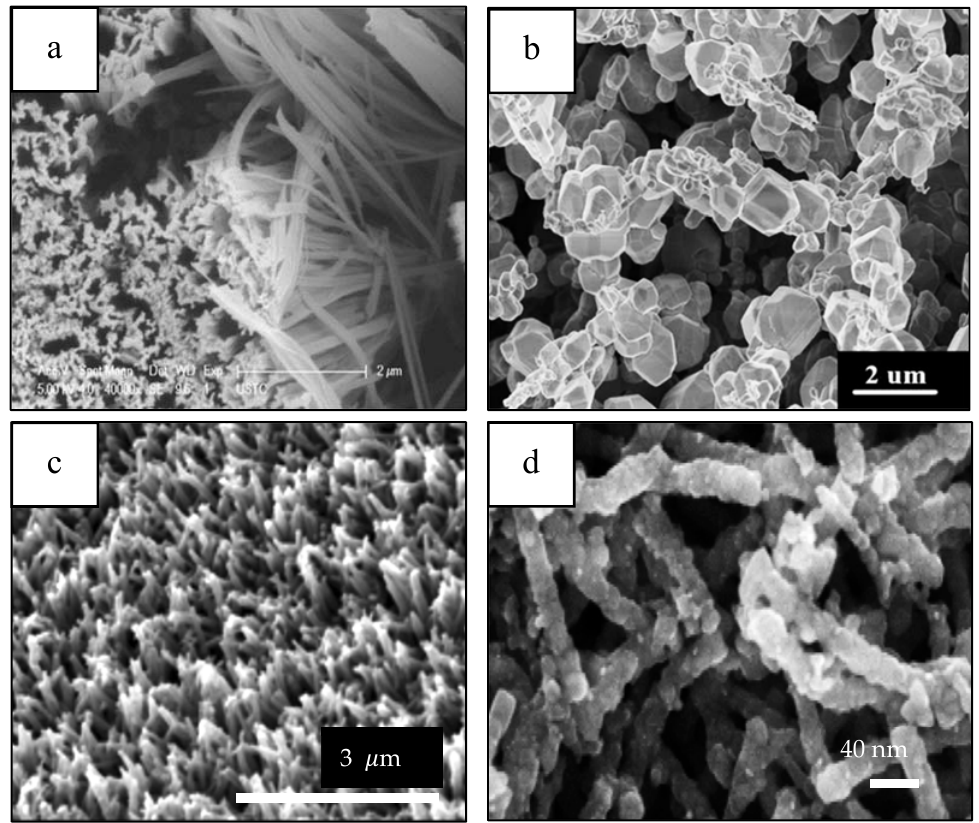
Figure 9. ( a ) Si nanowires [110], ( b ) C/Cu 2 O NWAs [111], ( c ) Co 3 O 4 nanorods [112], and ( d ) Ag/AgCl @ chiral TiO 2 nanofibers [113]. Reproduced with permission from references [110–113].